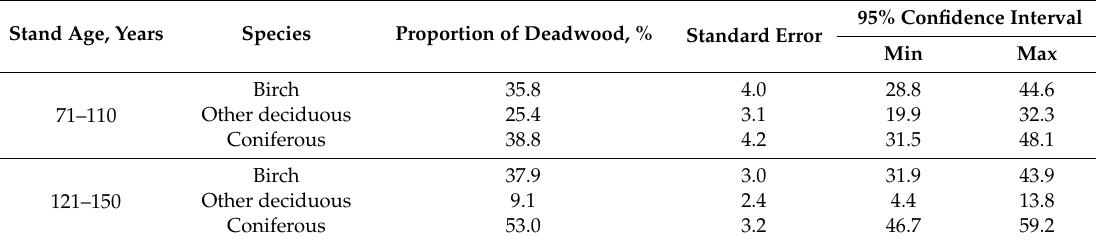
Table 2. Proportion of deadwood in recently unmanaged mature (71–110) and old-growth (121–150) stands by groups of species.